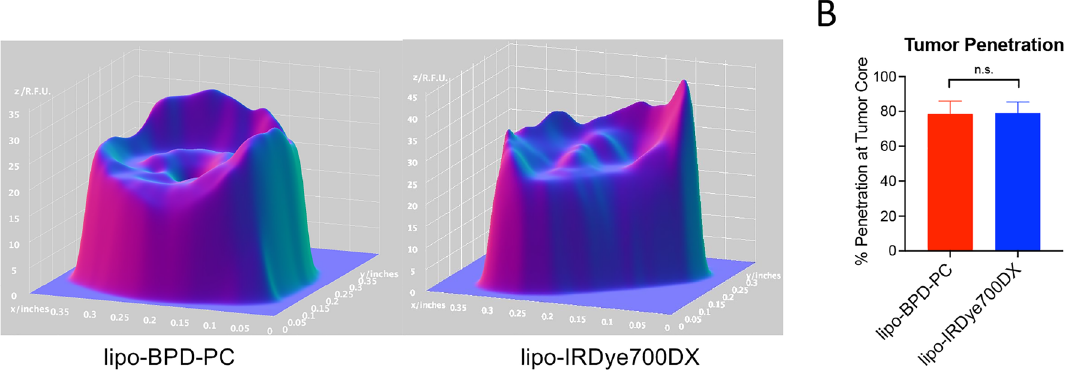
Figure 10: (A) Three-Dimensional projections of tumor penetration of lipo-IRDye700DX and lipo-BPD-PC in orthoptic FaDu tumors 24 h after administration. The x - and y -axis correspond to spatial dimensions (inches) and the z -axis corresponds to the fl uorescence intensities of the lipo-IRDye700DX and lipo-BPD-PC (R.F.U). (B) Quantitation of tumor penetration at the tumor core reveals no difference between lipo- IRDye700DX and lipo-BPD-PC. (Data are mean ± standard error; n ≥ 4 tumors per arm, statistical signi fi cance was calculated using one-way ANOVA with a Tukey